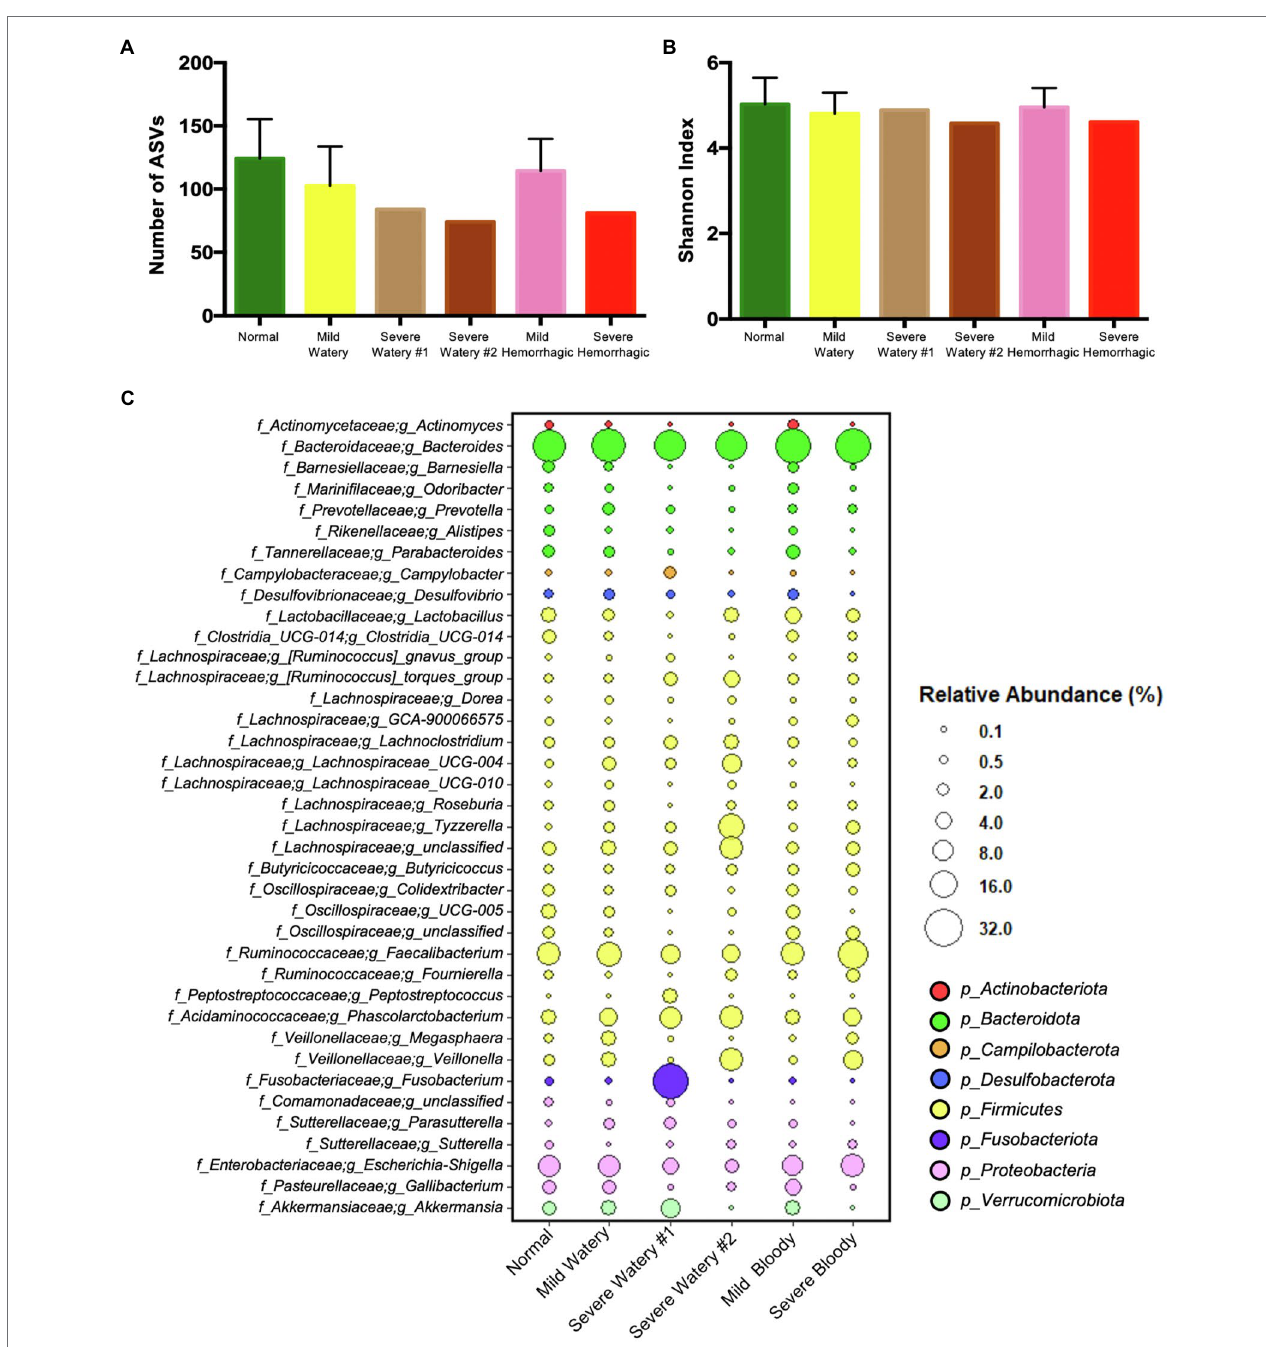
Figure 5 , we conducted antimicrobial activity of these strains against E. coli and S . Typhimurium, which can cause calf diarrhea (Boranbayeva et al., 2020). All Lactobacillus